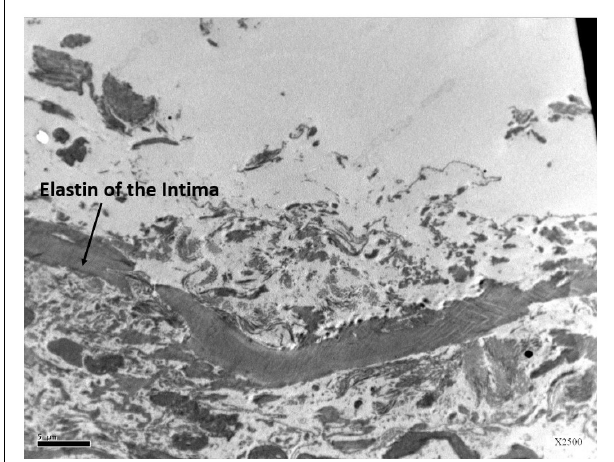
FIGURE 2 | Electron microscopy view of the luminal aspect of the blood vessels at the AHS sites. Only the elastin layer remained from the intima where the endothelial cells are